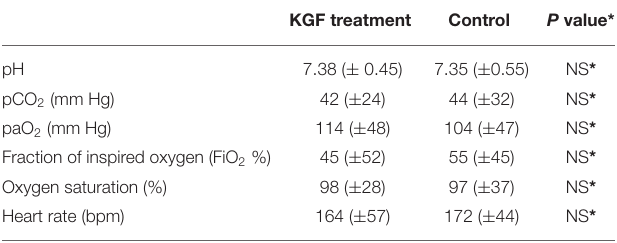
TABLE 2 | The ventilator and blood gas data for preterm pigs provided ventilation support for 24 h.